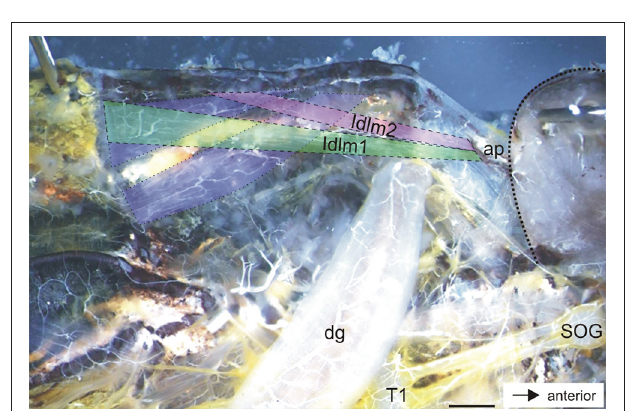
FIGURE 4 | Dorsal longitudinal neck muscles in the prothorax of A. paromalus . Dorsal longitudinal muscles are indicated by hatched lines and color coded for Idlm1 (green), Idlm2 (magenta), and two posterior muscles (blue). Dotted line indicates the outline of the head capsule. Scale = 1.5mm. ap, apodeme; dg, defense gland; SOG, subesophageal ganglion; T1, prothoracic